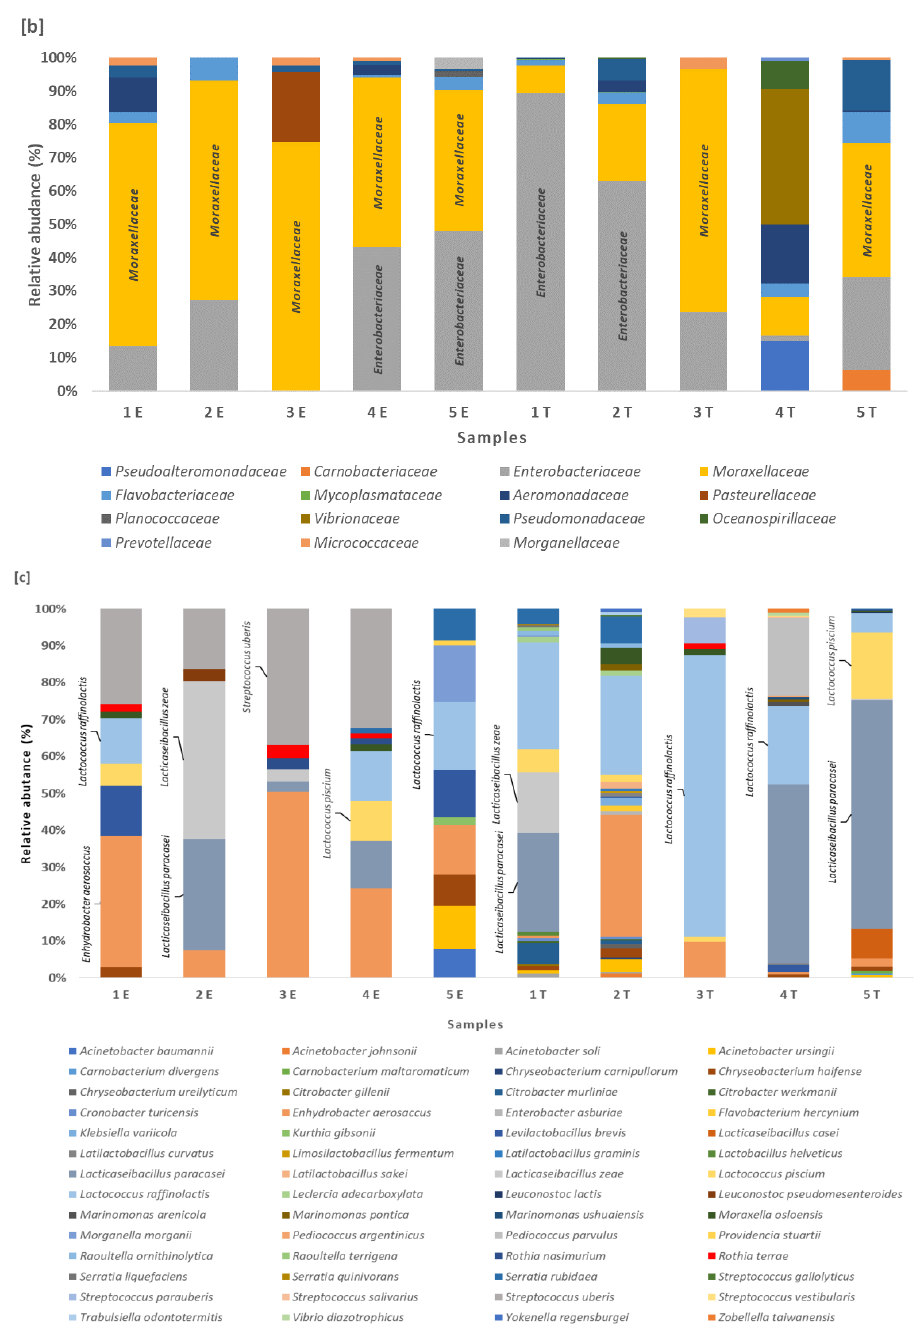
Figure 1. Bar plots of relative abundance (%) ( a ) of bacterial families across the sampling regions (E: Epirus; T: Thessaly). Bacterial families that did not reach the minimum of 0.01% were omitted; the family Streptococcaceae prevailed in all the samples, mainly due to the presence of the starter culture Streptococcus thermophilus , although there were obvious variations in percentages among the samples; ( b ) of bacterial families across the sampling regions after the exclusion of the families Streptococcaceae and Lactobacillaceae , to which the three main starter species belong; the background subdominant microbiota emerged, and especially the families Enterobacteriaceae and Moraxellaceae that have characteristic Gram-negative bacteria present in most food products of animal origin; ( c ) of bacterial species in all the feta cheese samples excluding the three starter LAB species Streptococcus thermophilus , Lactobacillus delbrueckii and Lactococcus lactis . The coding in the x -axis refers to the five samples from Epirus (1E–5E) and the five samples from Thessaly